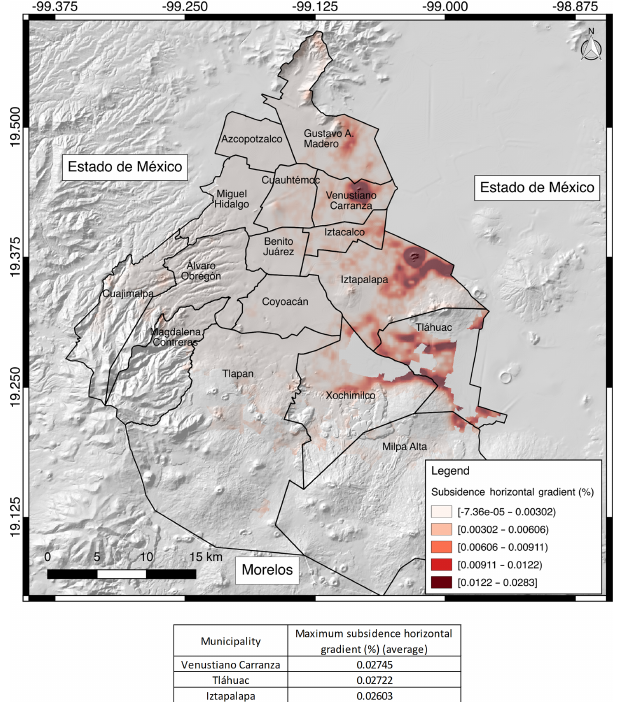
Figure 2. Subsidence Horizontal Gradient of Mexico City. The shaded topographic base layer is taken from Continuo de Eleva- ciones Mexicano 3.0. © Instituto Nacional de Estadística Geografía e Informática (INEGI).